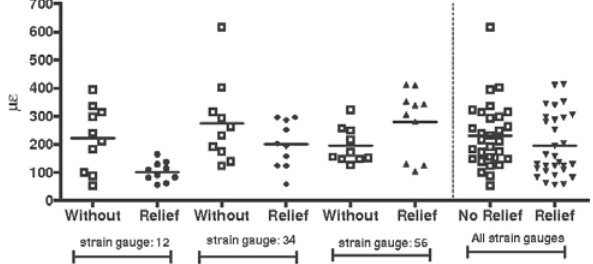
FIGURE 2- Device for analyzing the strain gauges of the test specimens